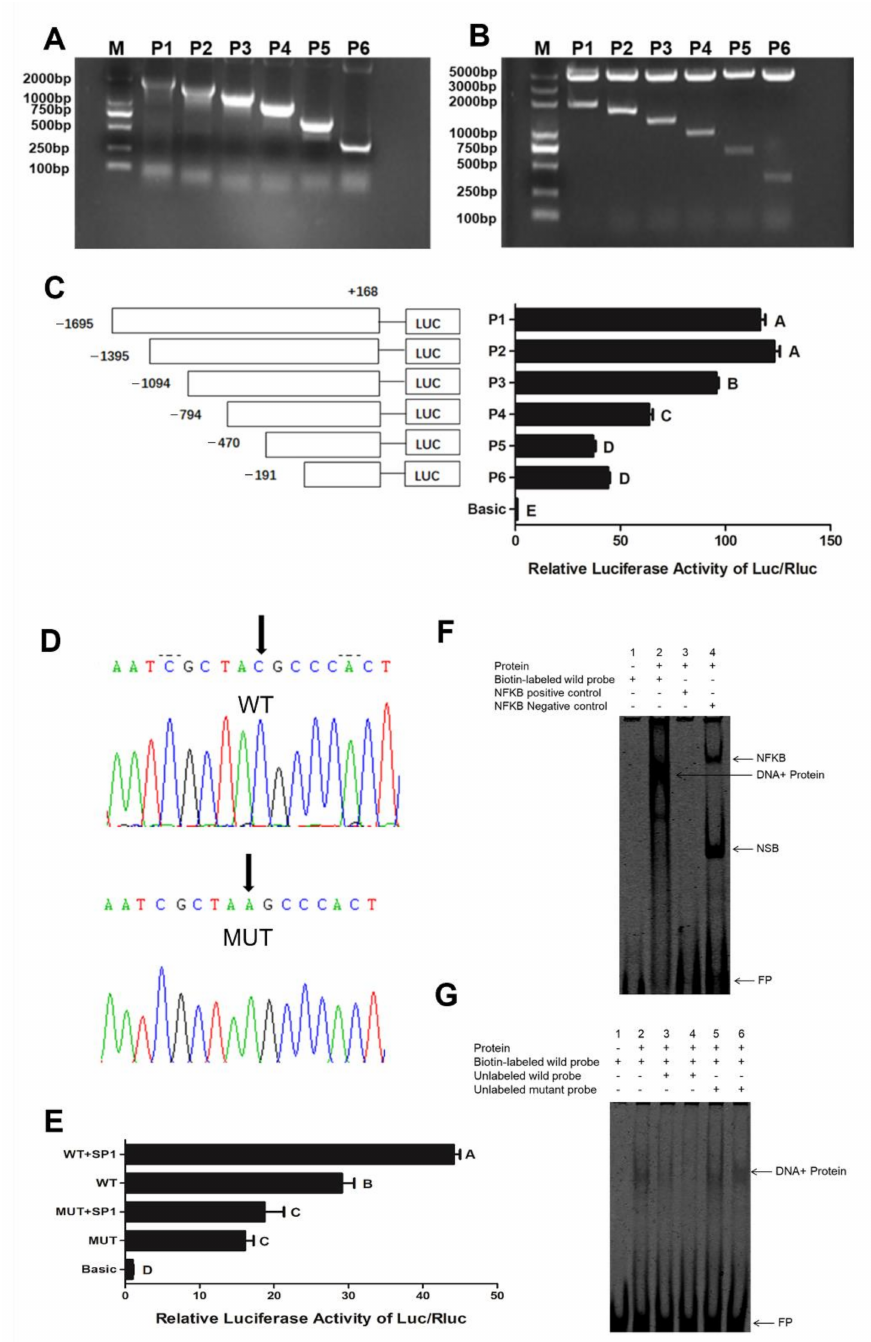
Figure 9. SP1 regulates the activity of the KRT17 promoter. ( A ) PCR amplification results of different promoter fragments; ( B ) double digestion results of different promoter fragment vectors; ( C ) luciferase activity of the different promoter fragments; ( D ) sequencing results of wild type (WT) and mutant (MUT) plasmids; ( E ) luciferase activity of mutant KRT17 promoter; ( F ) EMSA assay: Lane 1, empty probe; lane 2, test group; lane 3, negative control NFkB; lane 4, positive control NFkB; ( G ) competitive EMSA. Lanes 1 and 2 are negative and positive controls, lanes 3 and 4 are 33- and 100-fold unlabeled normal probes, and lanes 5 and 6 are 33-fold and 100-fold unlabeled mutant probes for competition reactions, respectively. NFkB was a positive binding protein, DNA + Protein denotes SP1 binding, NSB was the non-specific binding protein, and FP denotes free probe. Different letters indicate significant